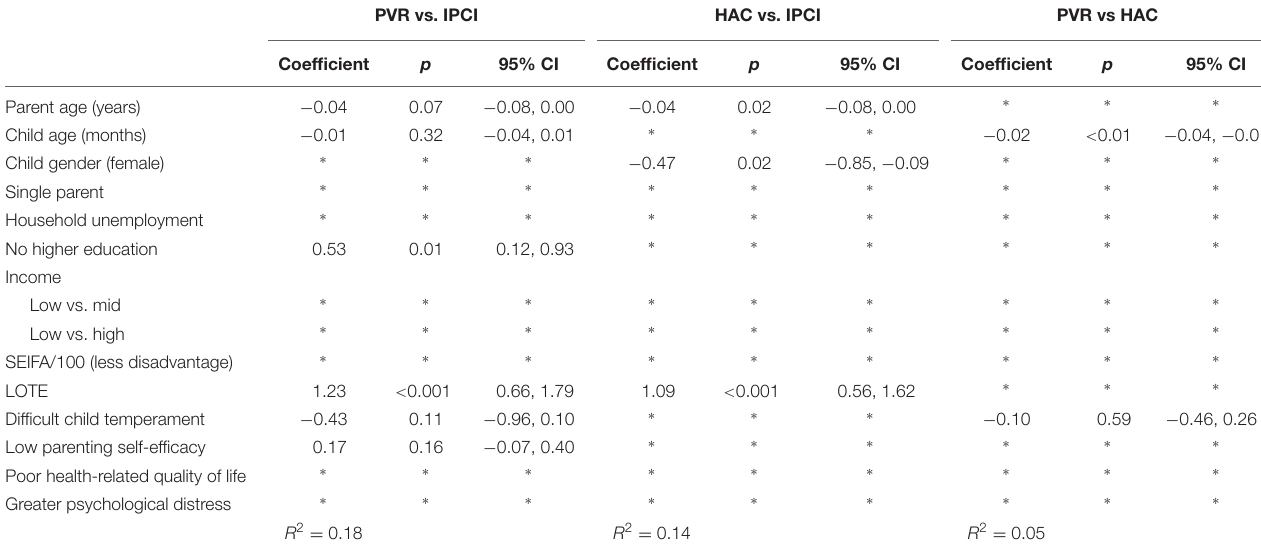
TABLE 7 | Adjusted analysis for the Early Home Learning Study difference scores and socio-demographic factors (parenting behavior measures). PVR vs. IPCI HAC vs. IPCI PVR vs